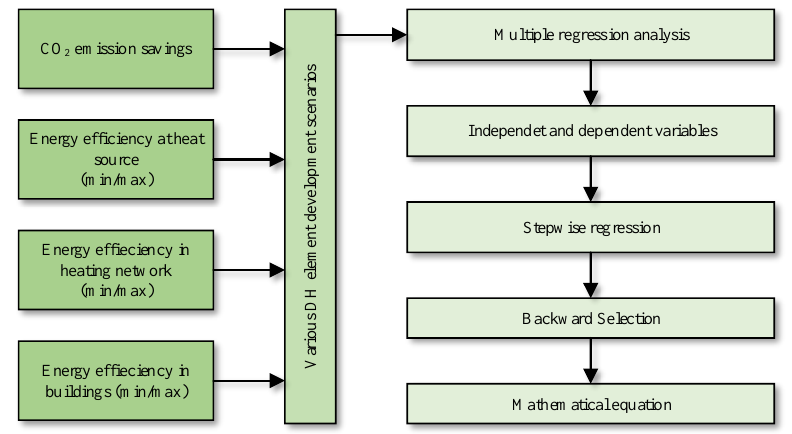
Fig. 2. Algorithm for CO 2